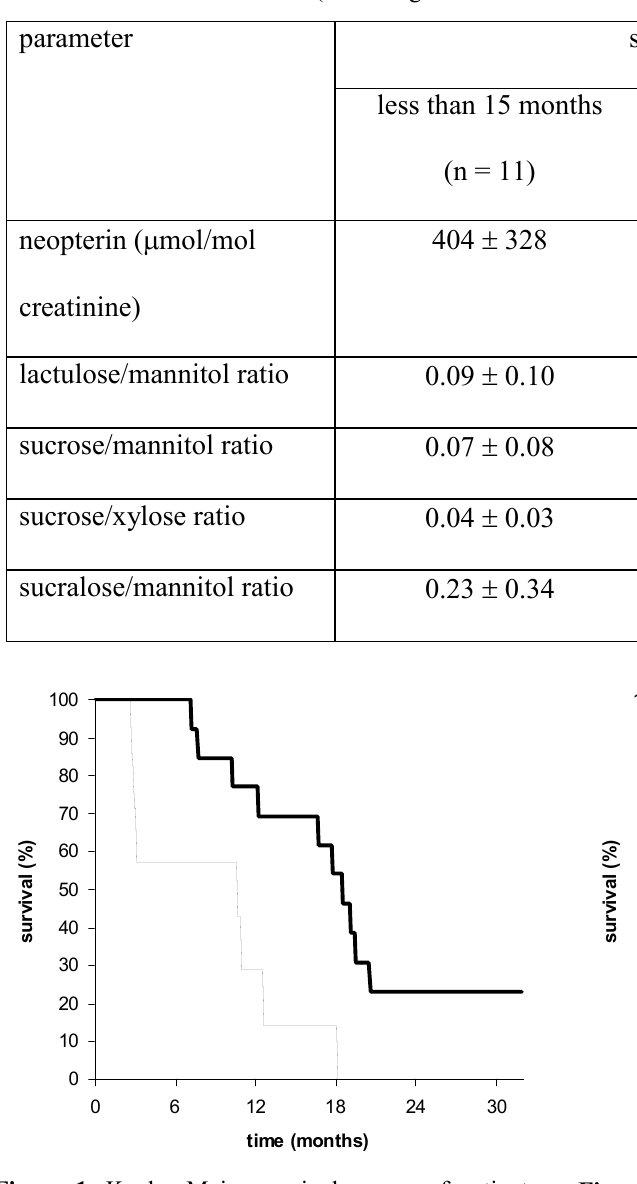
Figure 2. Kaplan-Meier survival curves of patients with neopterin below (full line) versus equal or above (dashed line) 220 µ mol/mol creatinine. The respective median survival was 10.6 vs. 18.4 months (log-rank test, p =